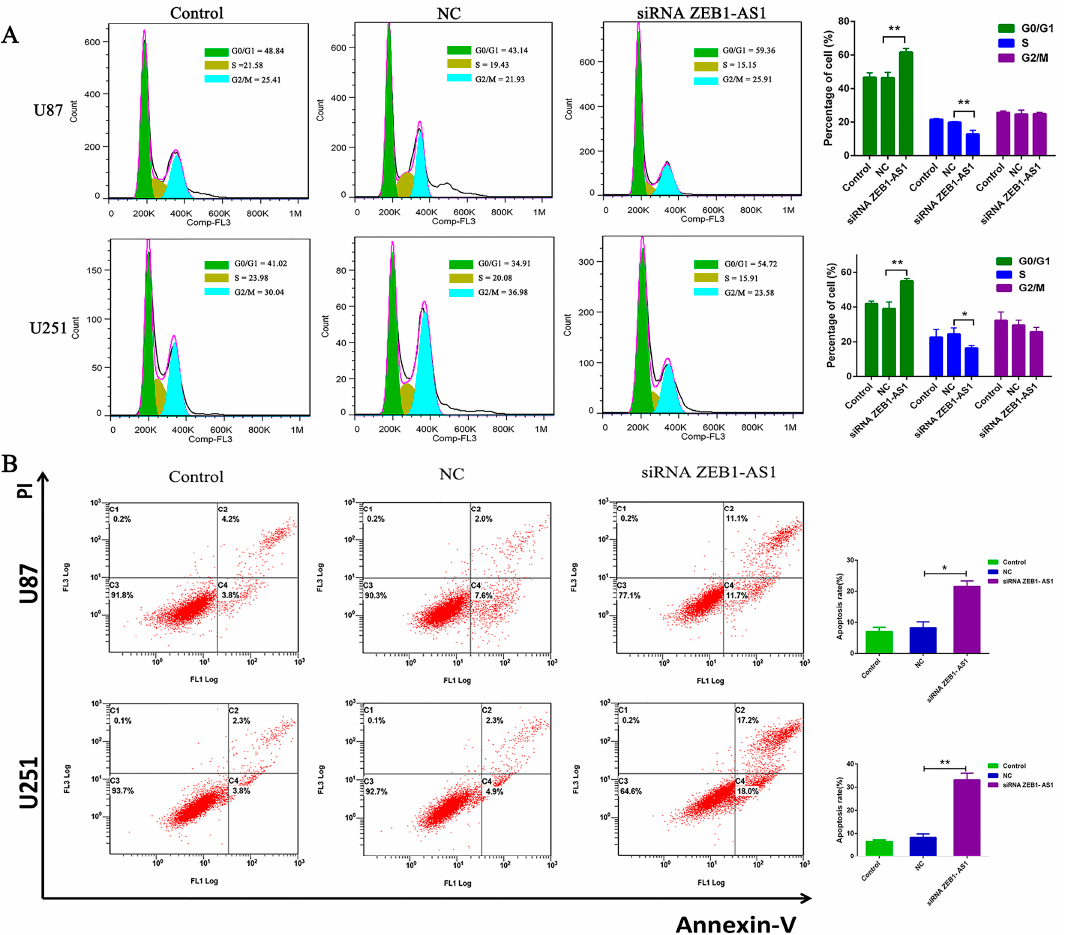
Figure 3. Effects of lncRNA ZEB1-AS1 on glioma cell cycle and apoptosis were analyzed by flow cytometry. ( A ) Cell cycle analysis showed that the silencing of ZEB1-AS1 greatly induced the G0/G1 phase arrest and correspondingly decreased the percentage of S phase cells; ( B ) Annexin V/PI (propidium iodide) staining and flow cytometry analysis showed that ZEB1-AS1 knockdown in U87 and U251 cells dramatically enhanced the cell apoptosis rate compared with NC groups. * p < 0.05, ** p < 0.01.